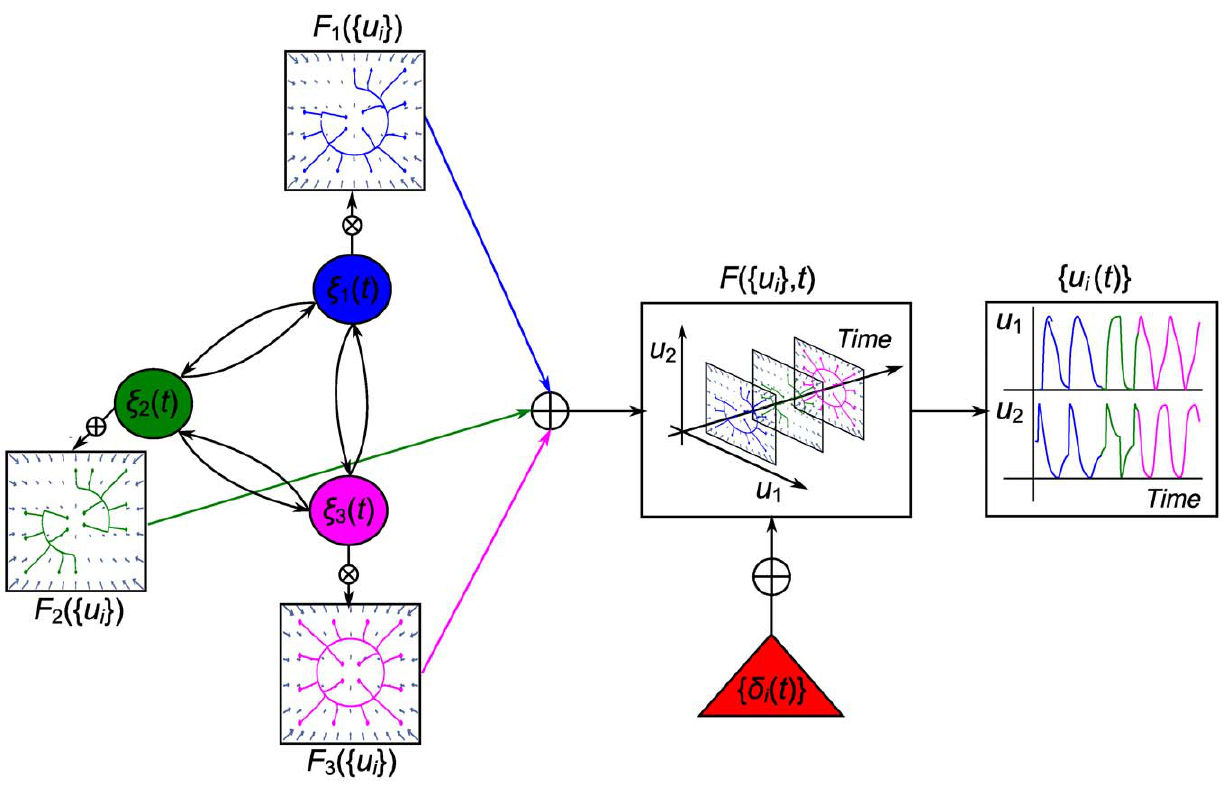
Figure 2. Functional modes and architecture overview. Interactions among functional modes F j ({ u i }) result in one of them dominating the output of the functional architecture for a period of time followed by the domination of another one via a fast transient. Three modes (associated with different colors) of the available dynamic repertoire are shown. They all correspond to 2-dimensional phase flows on an ellipsoid manifold. Blue represents a monostable phase flow, magenta a limit cycle flow, and green a bistable flow. Their vector field and a set of characteristic trajectories starting from different initial conditions (small asterisks) are shown. The modes’ mutual interactions are depicted as bidirectional couplings (arrows) among their associated weighting coefficients { j j (t)} (with which they have a multiplicative relationship). The resulting expressed phase flow F({u i },t) (shown as a trajectory in the phase space and time) results from their linear combination at each time moment, while {u i (t)} is the respective time series. { j j (t)} play the role of a slow operating signal (with respect to the inherent time scale of the functional modes, i.e., t j .. t f ). Finally, an instantaneous ( t d ,, t f ) operational signal { d i ( t )} (in red) may have an additive contribution to F ({ u i }, t ), acting like a meaningful perturbation.